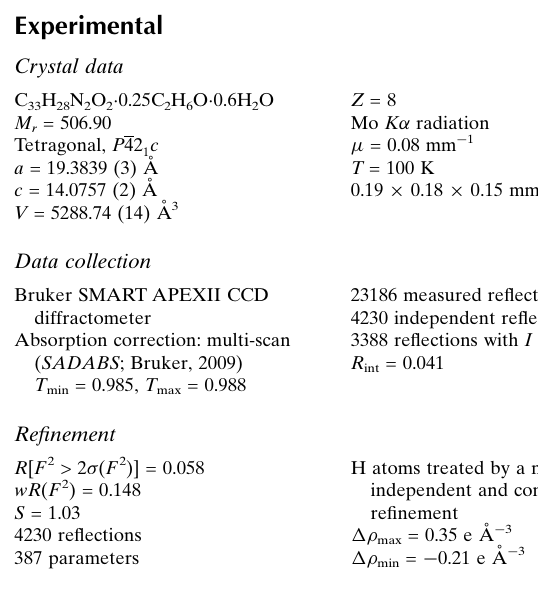
Absorption correction: multi-scan ( SADABS ; Bruker, 2009)